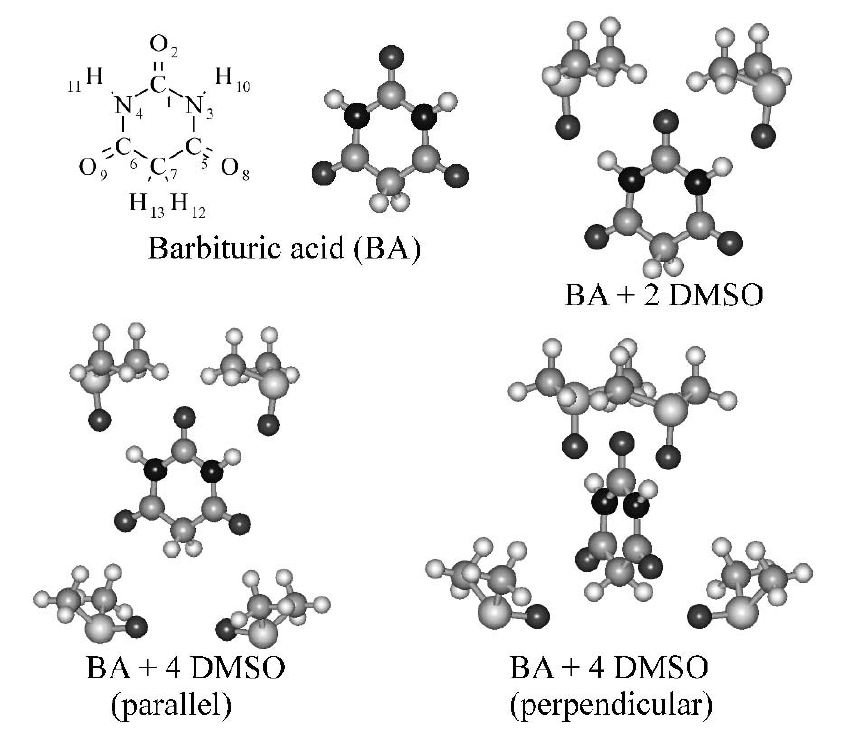
Fig. 1 Atom numbering scheme and molecular structures of the barbituric acid and its associates with DMSO molecules studied in this